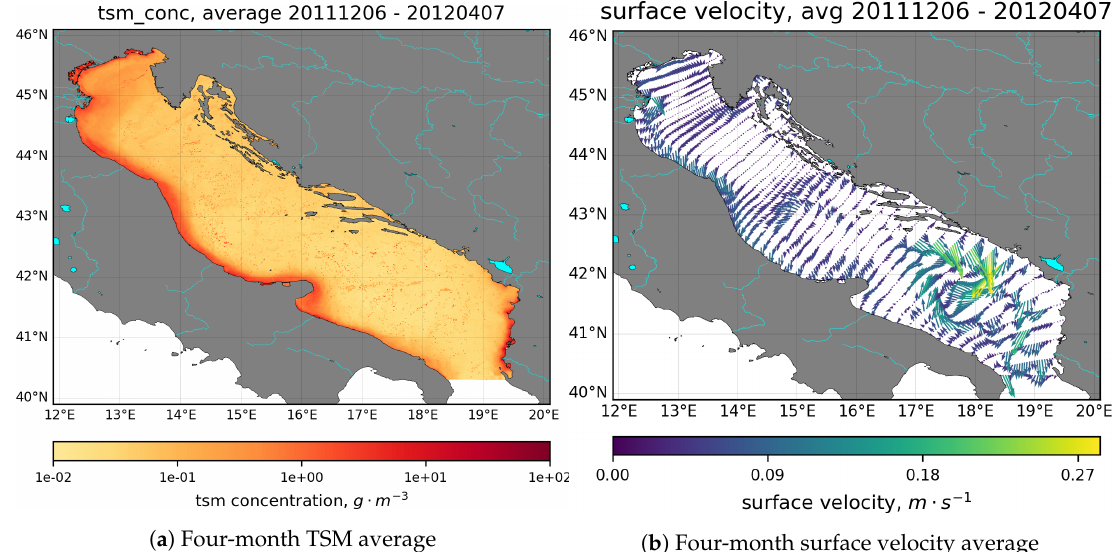
Figure 5. Source data: Four-month averages (from 6 December 2011 to 7 April 2012) of surface TSM concentration ( a ) and surface velocity field ( b